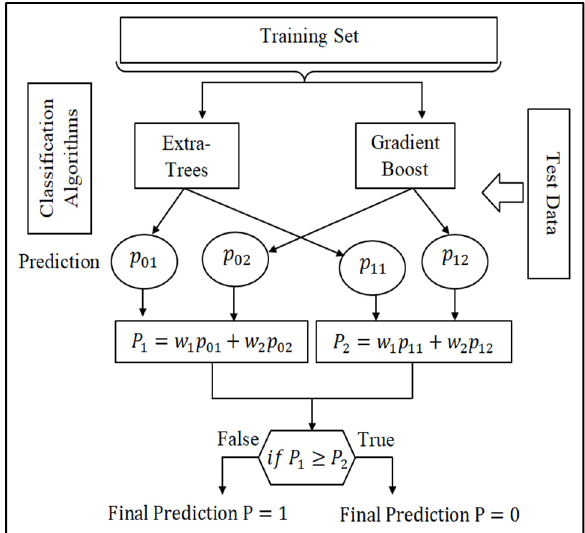
Figure 8. Ensemble classification model based on weighted soft voting for abnormal contracts de-